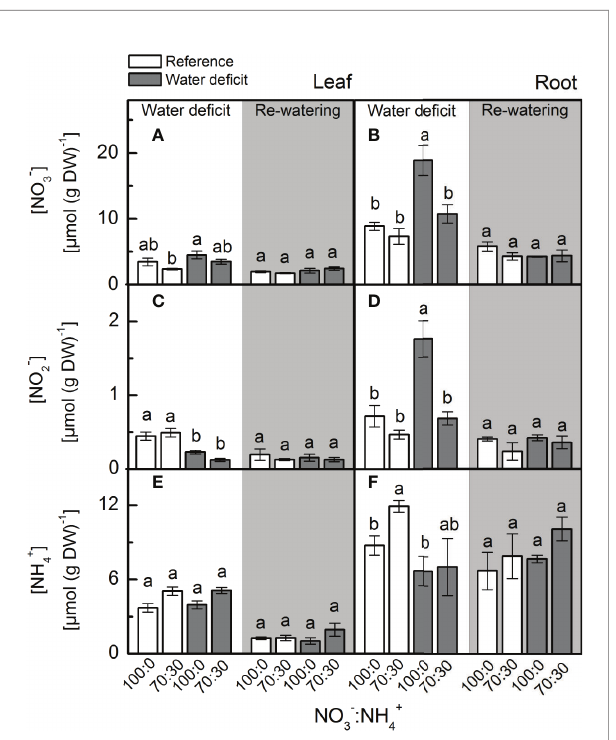
FIGURE 2 | Nitrate reductase activity [NR, in (A, B) ], S-nitrosoglutathione reductase activity [GSNOR, in (C, D) ] and S-nitrosothiol concentration [SNO, in (E, F) ] in leaves (A , C , E) and roots (B , D , F) of sugarcane plants maintained well-hydrated (reference, white bars) or subjected to water de fi cit (gray bars) and supplied with varying NO 3 − :NH 4+ ratios: 100:0 and 70:30. The white area indicates the period of water de fi cit and the shaded area indicates the period of re-water. Bars represent the mean value of four biological replicates ± se. Different letters indicate statistical difference (BF 10 > 3) among treatments in a given